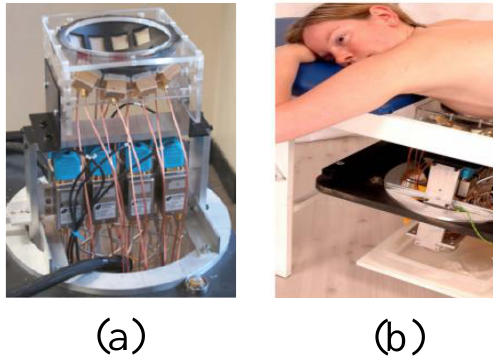
Figure 16. Prototype UWB frequency-domain radar-based MI system developed by Klemm et al. [76]. ( a ) View of the breast holder consisting of a conformal MI array, feed, and a switching system. ( b ) A photo of the prototype system setup for breast cancer detection showing a healthy female volunteer lying in a prone position. Reprinted with permission from [76].